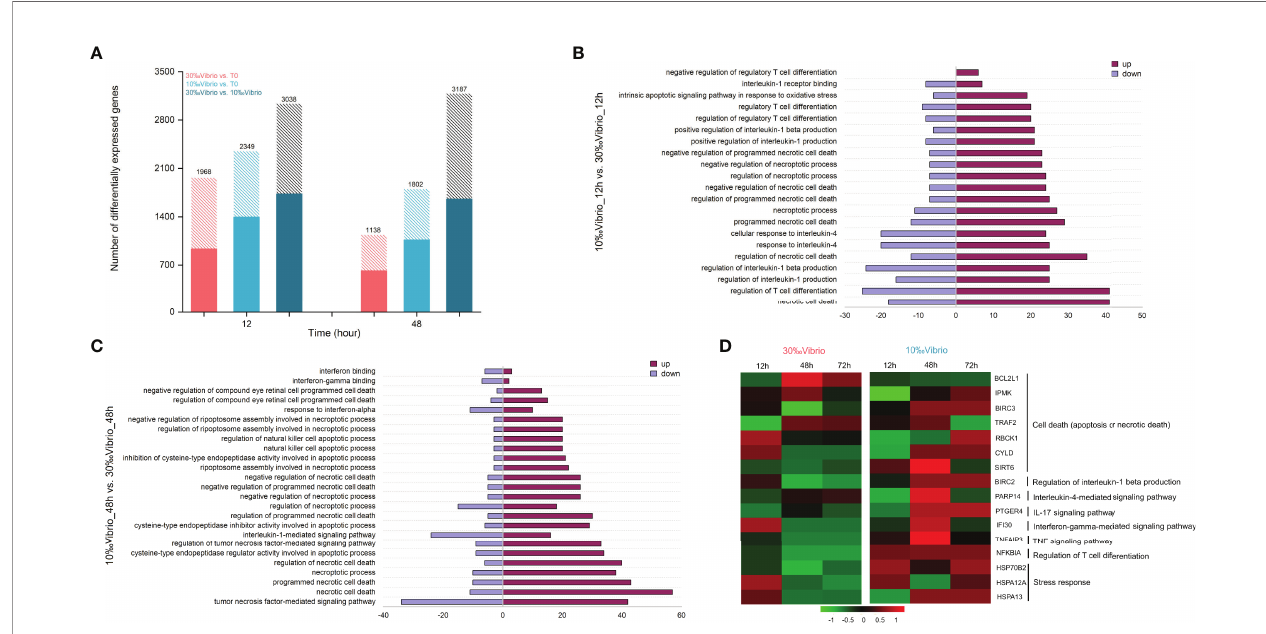
FIGURE 4 | Comparative transcriptome pro fi ling of V. alginolyticus infected oysters exposed to salinity of 10 ‰ and 30 ‰ . (A) Identi fi cation of differentially expressed genes between V. alginolyticus infected oysters exposed to normal salinity (30 ‰ ) and low salinity (10 ‰ ) at 12h and 48h post infection. The fi lled colored bars indicated number of genes that were expressed at higher levels, while hashed bars indicated number of genes expressed at lower levels. (B) GO categories associated with necrotic cell apoptosis or death and in fl ammation that were signi fi cantly enriched at 12h. The red-colored bars indicated number of genes that were expressed at higher levels in 10 ‰ Vibrio oysters, while purple-colored bars indicated number of genes expressed at higher levels in 30 ‰ Vibrio oysters. (C) GO categories associated with necrotic cell apoptosis or death and in fl ammation that were signi fi cantly enriched at 48h. The red-colored bars indicated number of genes that were expressed at higher levels in 10 ‰ Vibrio oysters, while purple- colored bars indicated number of genes expressed at higher levels in 30 ‰ Vibrio oysters. (D) Veri fi cation of expression pro fi les of genes associated with necrotic cell apoptosis or death and in fl ammatory response. Differential expression analysis was performed between each time point and time zero. The intensity of the color from green to red indicates the magnitude of differential expression in log 2